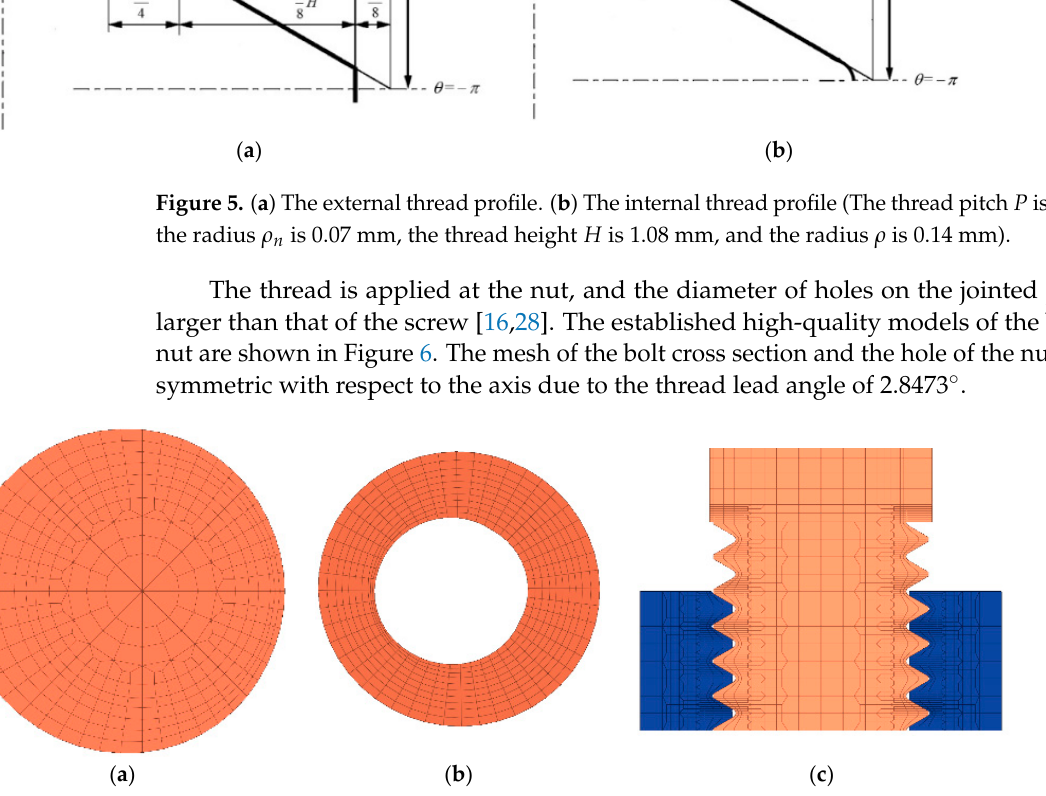
Figure 6. Finite element models of the bolt and nut: ( a ) cross section of bolt, ( b ) cross section of nut, ( c ) cross section of bolt and nut assembly.